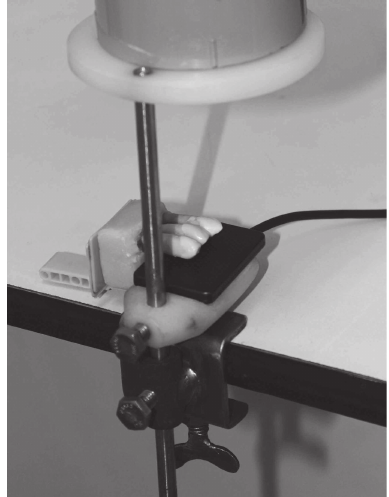
Figure 1: Device used to obtain interproximal